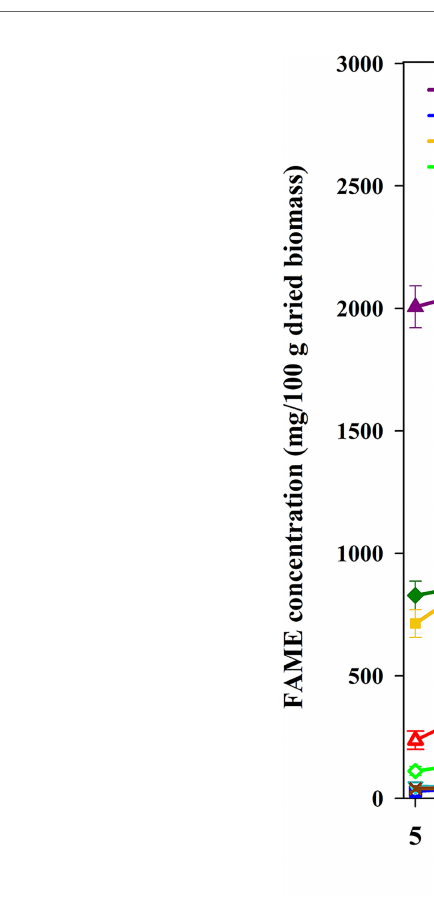
FIGURE 3 | TThe growth curve of eight important FAME components of C. vulgaris